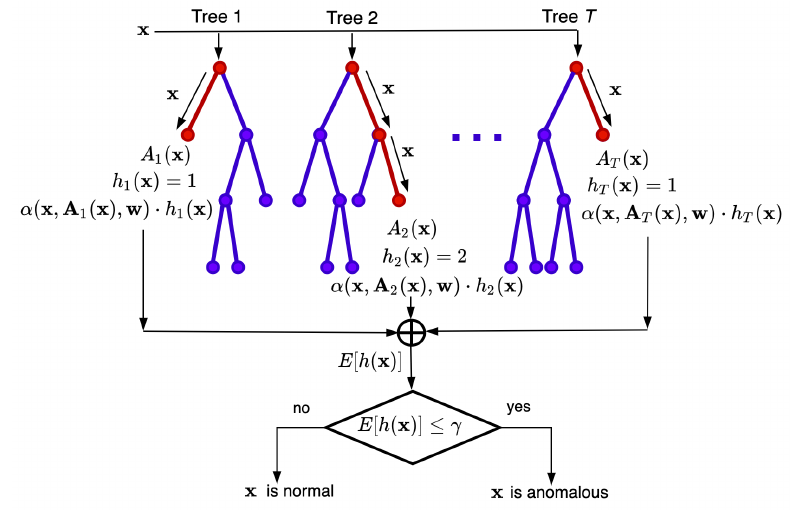
Figure 1. A general scheme of ABIForest, which illustrates how iForest is modified by incorporating an attention